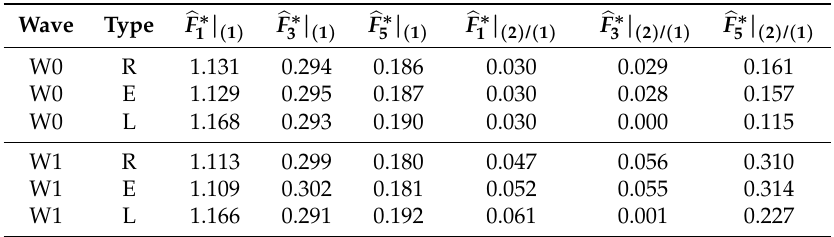
Table 7. Prototype scale force amplitudes for the fixed WEC. in mode i . Simulation types are headlined: R for RANS; E for Euler; and L for linear. See Table 4 for non-dimensionalisation